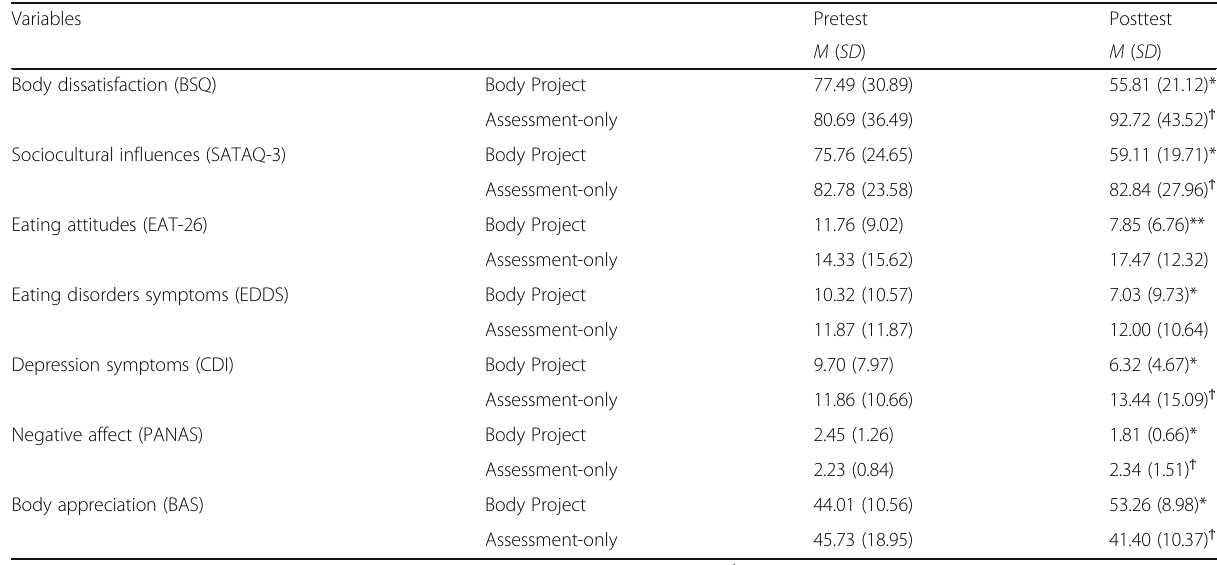
Table 2 Means and standard deviations for the intervention participants and assessment-only group on the outcome variables Variables